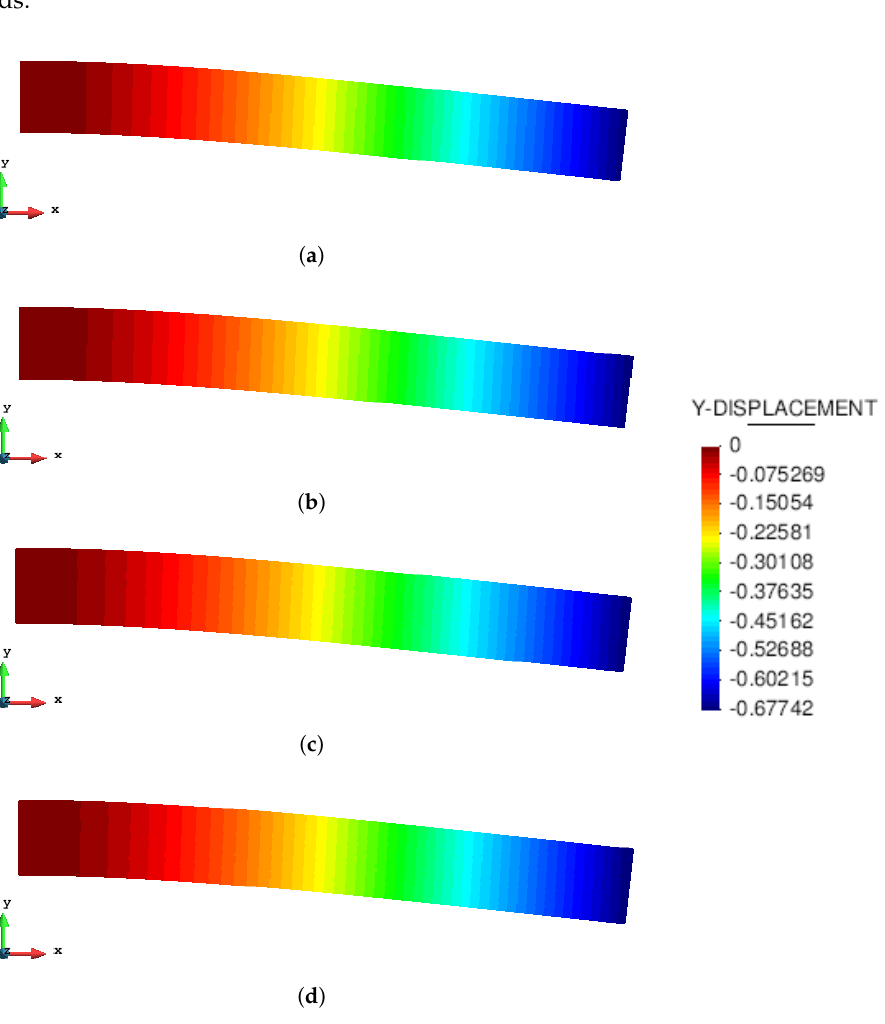
Figure 5. Static cantilever. Displacement along the y-direction.( a ) FEM code; ( b ) MPM code; ( c ) GMM-MLS code; ( d ) GMM-LME